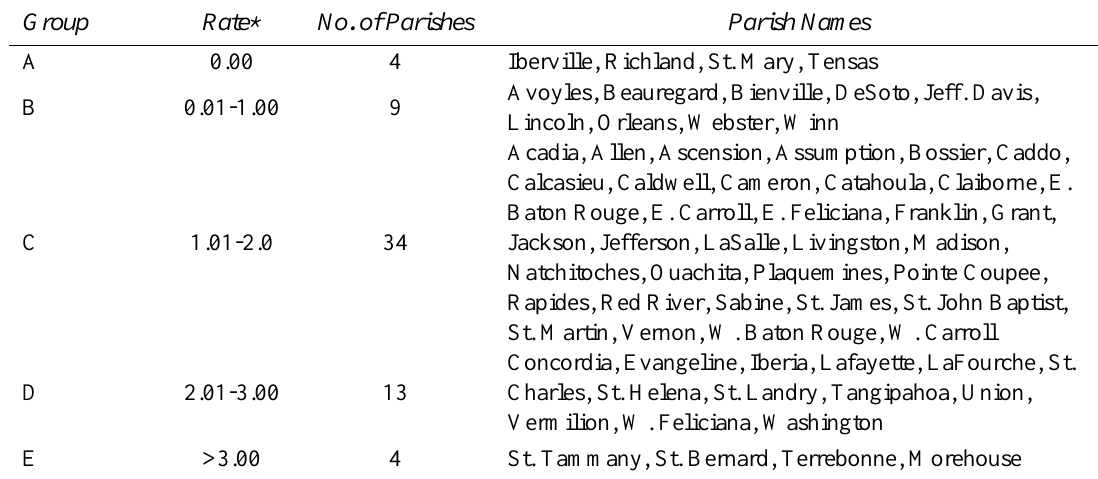
Table 8: Distribution of salmonella in various parishes for the year 2001.